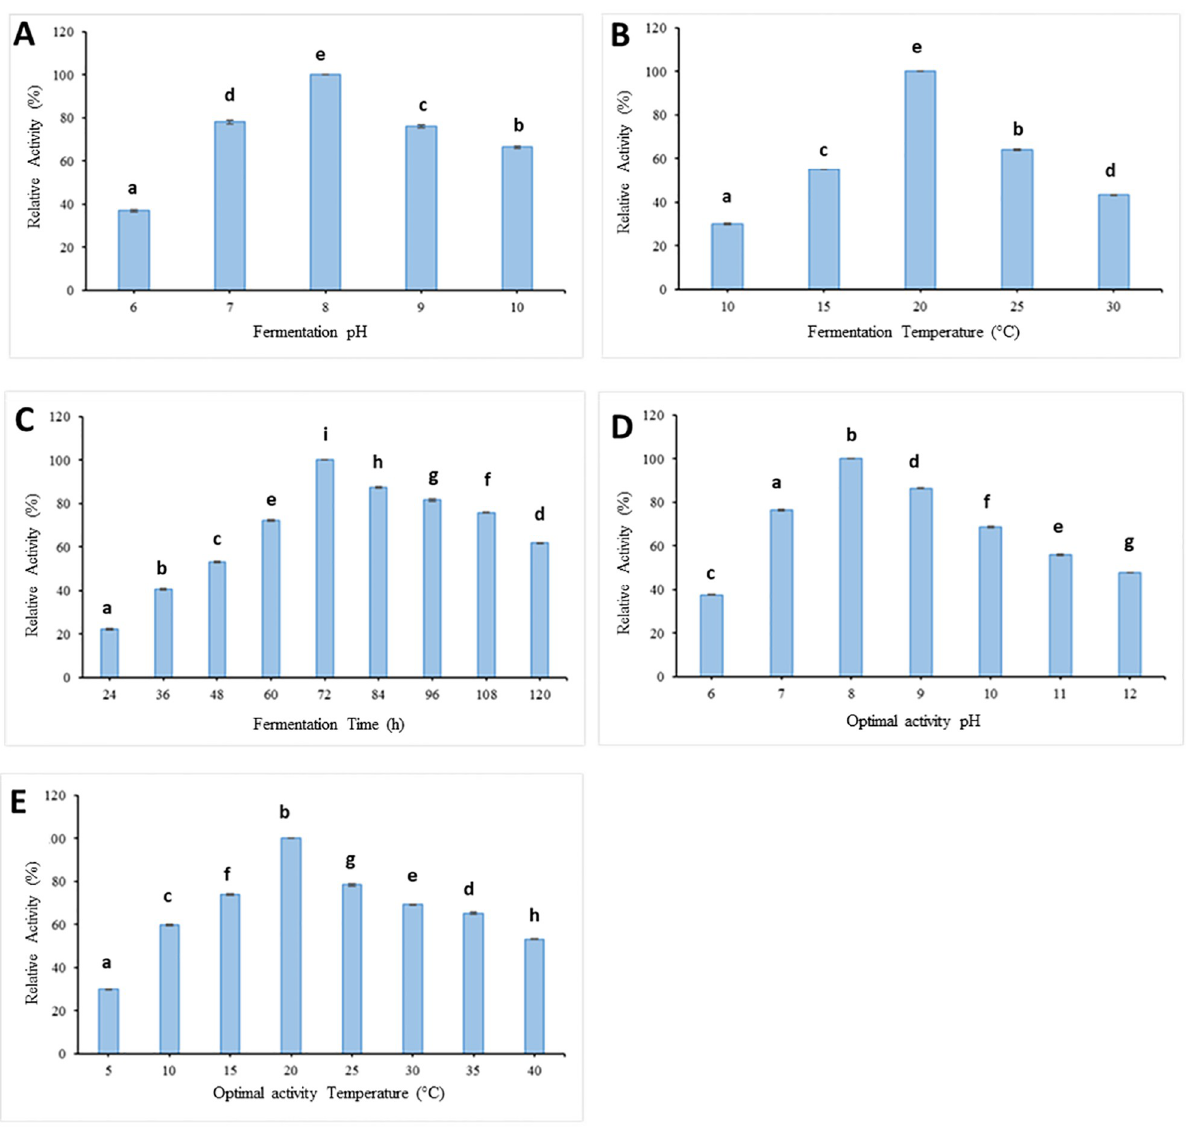
Fig 2. (A, B, C). Optimization of protease production by isolate HM49 (2A- fermentation pH; 2B- fermentation Temperature; 2C-fermentation Time). Isolate HM49 depicted optimal enzyme production in pH 8.0 at 20 ˚C post 72h incubation period. The data in figures represent mean standard deviation (Mean ± SD) of three independent replicates with different letters above the bars indicating significant enzyme activity at p = < 0.05 significance level. (D, E). Effects of varying pH and temperature on protease activity. Isolate HM49 recorded its protease enzyme activity from pH 6 (lowest) reaching its optimum at pH 8 followed by a gradual decrease up to pH 12 (2D). Temperature studies revealed its dynamism broadly in 5˚C (lowest) to 40 ˚C range with its optimum activity being recorded at 20 ˚C (2E). The data in figures represent mean standard deviation (Mean ± SD) of three independent replicates with different letters above the bars indicating significant enzyme activity at p = < 0.05 significance level.